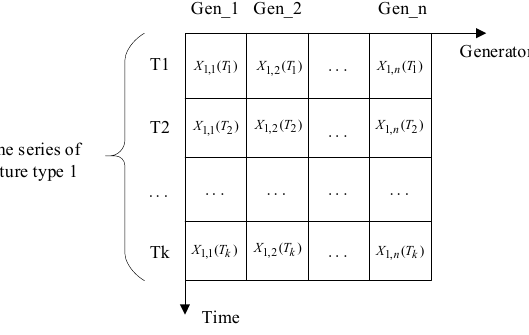
Figure 1. Time series of voltage magnitude of all the generators.